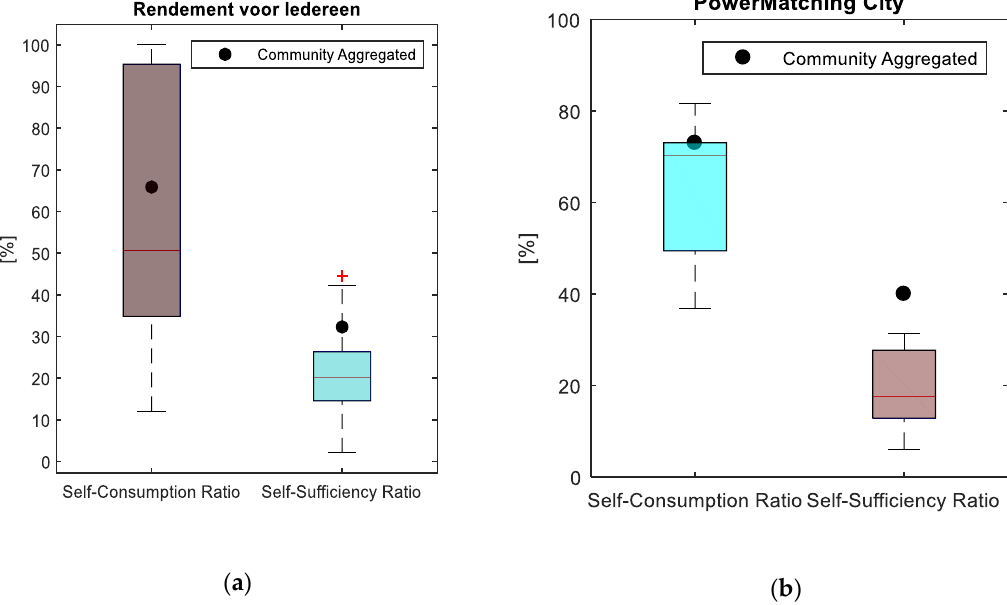
Figure 6. Boxplots of annual self-consumption and self-sufficiency ratios. (a) results for Rendement voor Iedereen pilot and (b) for Power Matchig City. For each box, the red line indicates the median, and the bottom and top edges of the box indicate the 25th and 75th percentiles, respectively. The whiskers extend to the most extreme data points without considering the outliers, and the outliers are plotted individually in red. The black dots represent the community aggregated values for self-consumption and self-sufficiency.